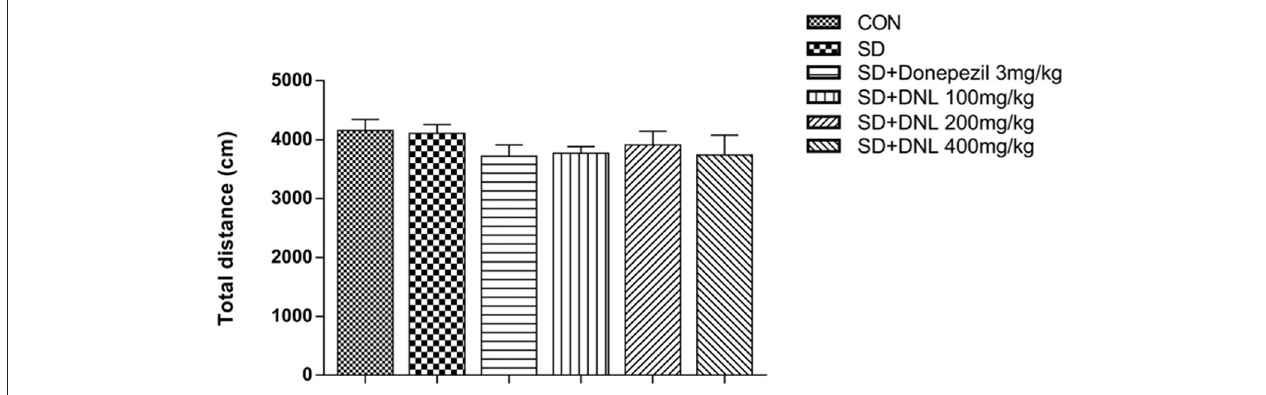
FIGURE 3 | The effect of DNL on the locomotor activities in the open field test after SD for 2 weeks in mice. Values are mean ± SEM, n =